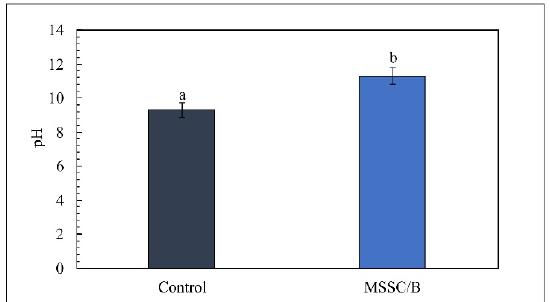
Figure 3. Soil pH after MSSC/B application after the completion of the phytostabilization experiment. Mean ± SD with different lowercase letters indicate significant differences among treatments ( p < 0.05) using one-way ANOVA.